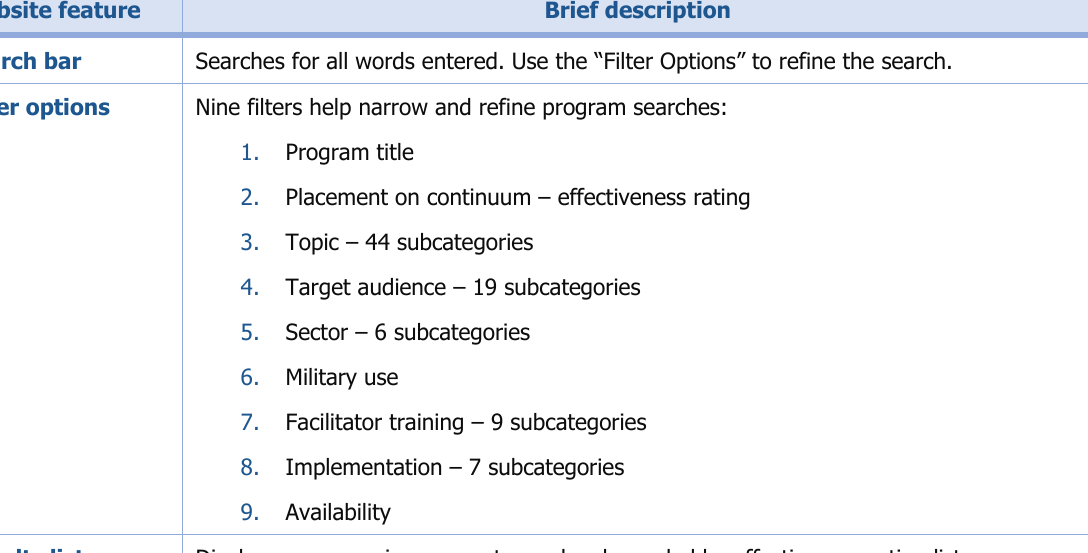
Table 2. Clearinghouse Website “Continuum of Evidence” Features Website